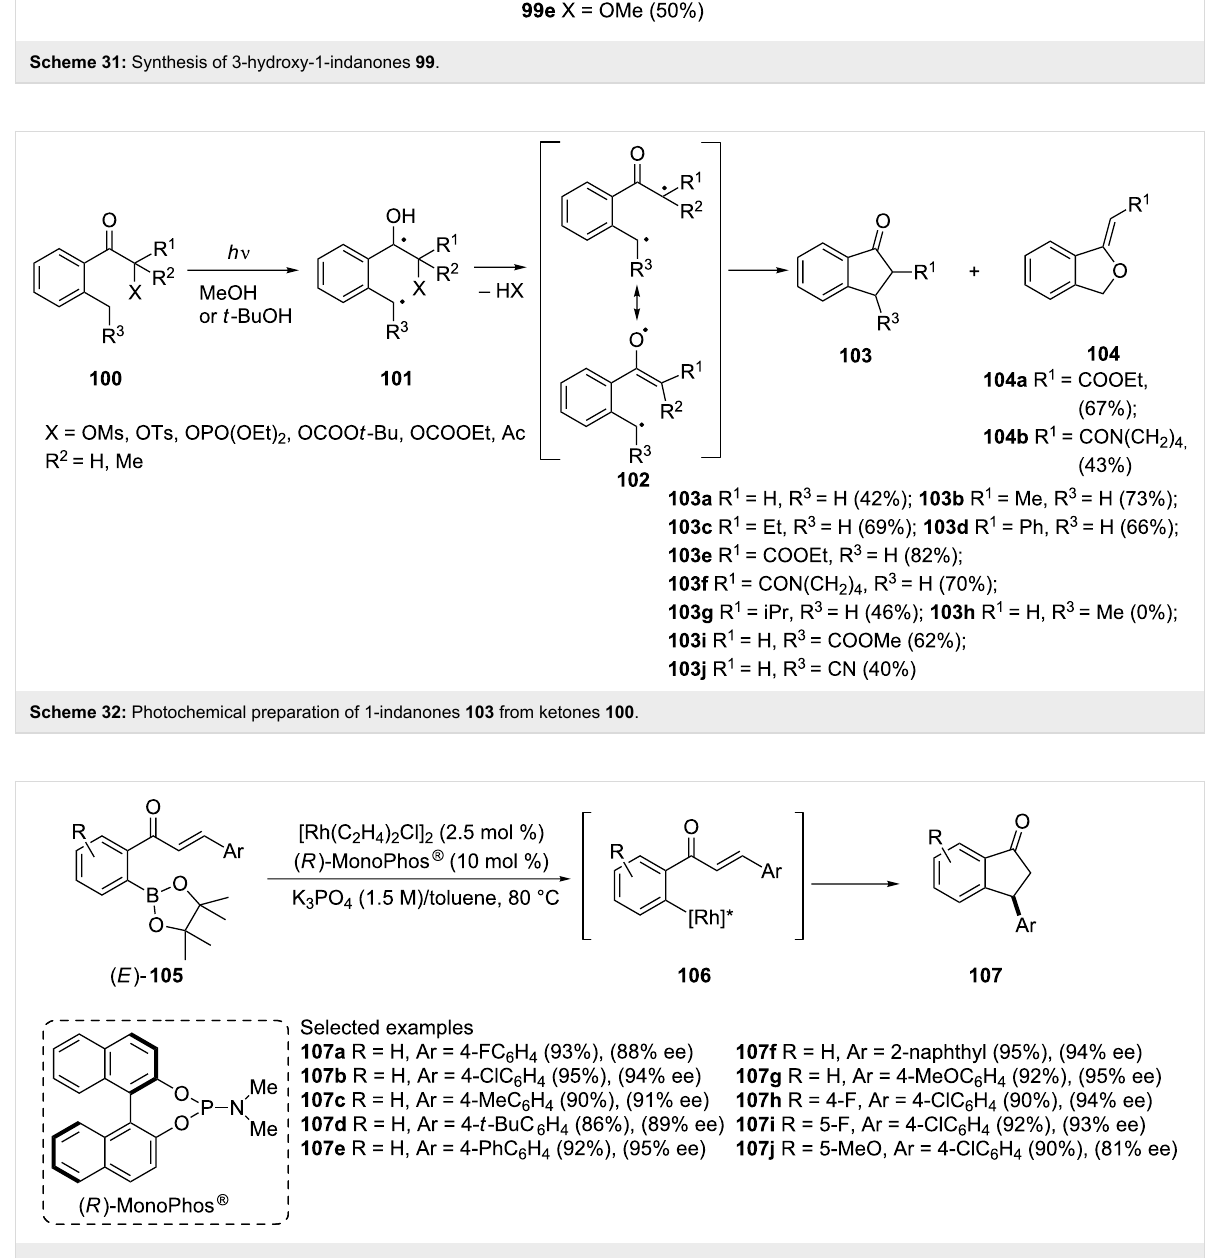
Scheme 33: Synthesis of chiral 3-aryl-1-indanones 107